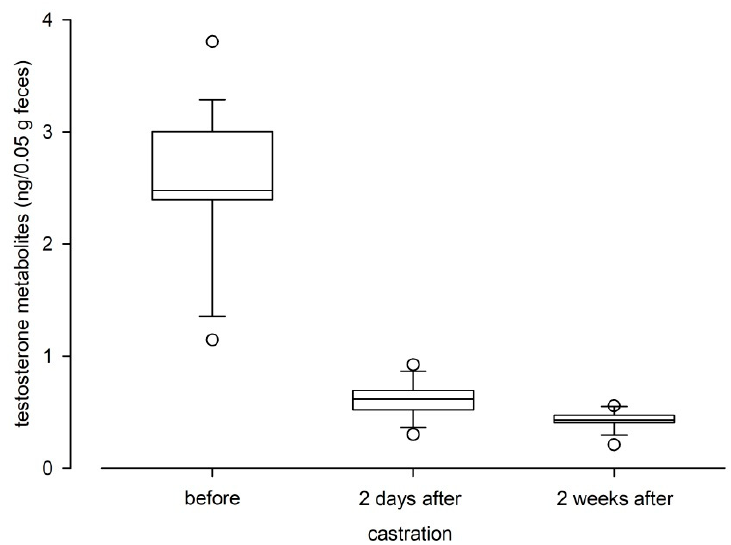
Figure 5. Testosterone metabolite levels in male C57BL/6J mice (n = 8) for 24 h without prior hCG administration (baseline; white boxplots) and for 24 h post hCG administration (grey boxplots).